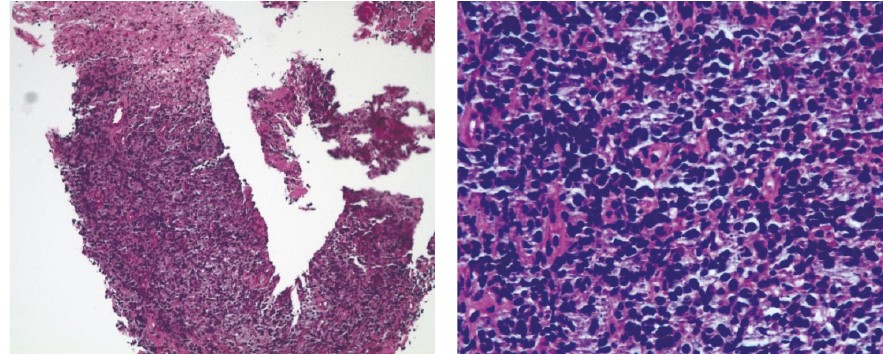
Figure 5: Histopathology slide showing large amount of lymphocytes.